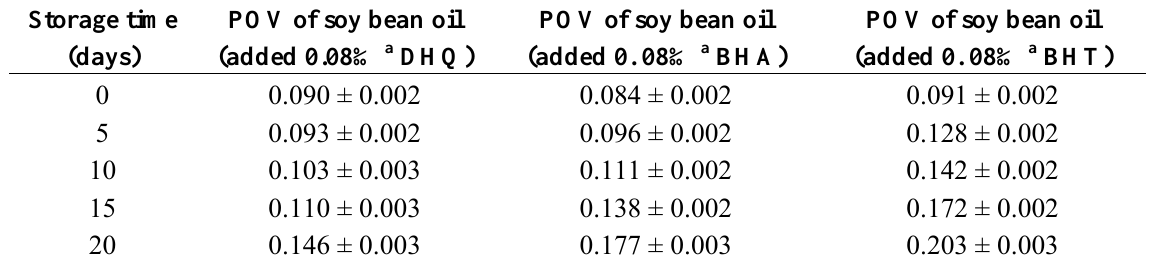
Table 4. POV of soy bean oil after addition of synthetic antioxidants during storage at 25 °C. Storage time